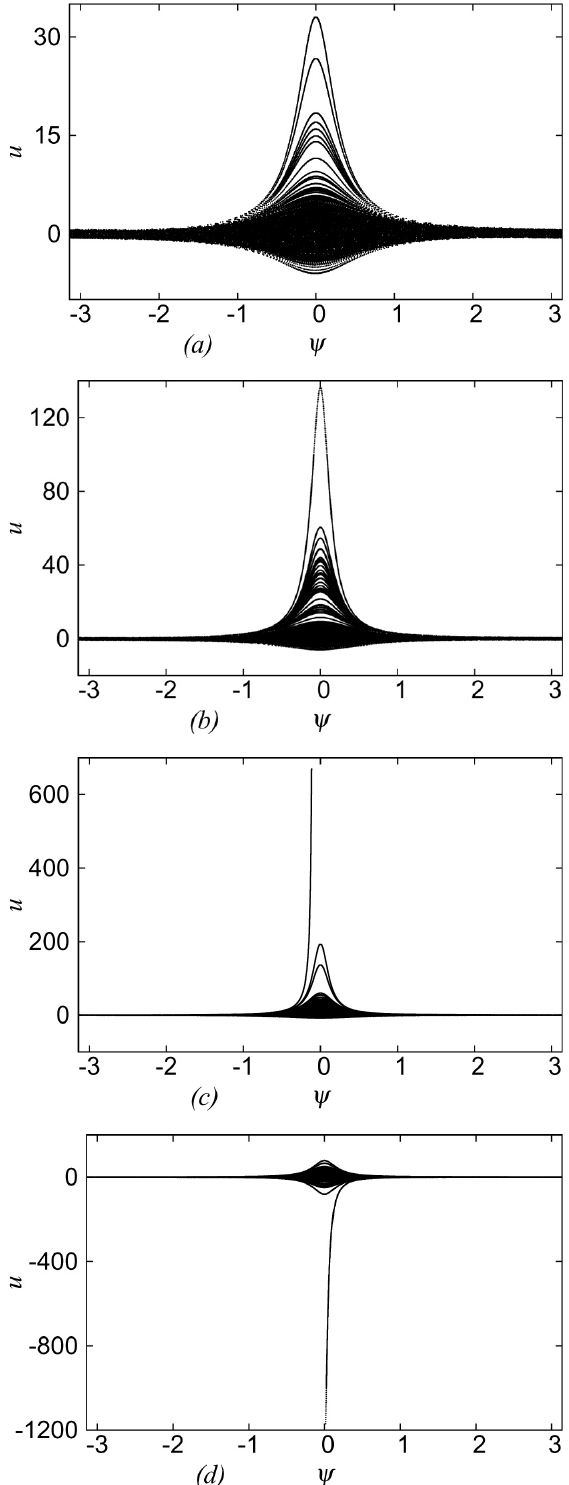
Fig. 13. Phase space u,ψ for the map (121) at Q = 0 . 367. Number of iterations increasing from (a)–(c) and (d) as N = 4 . 2 × 10 4 ; 8 × 10 4 ; 2 . 2 × 10 5